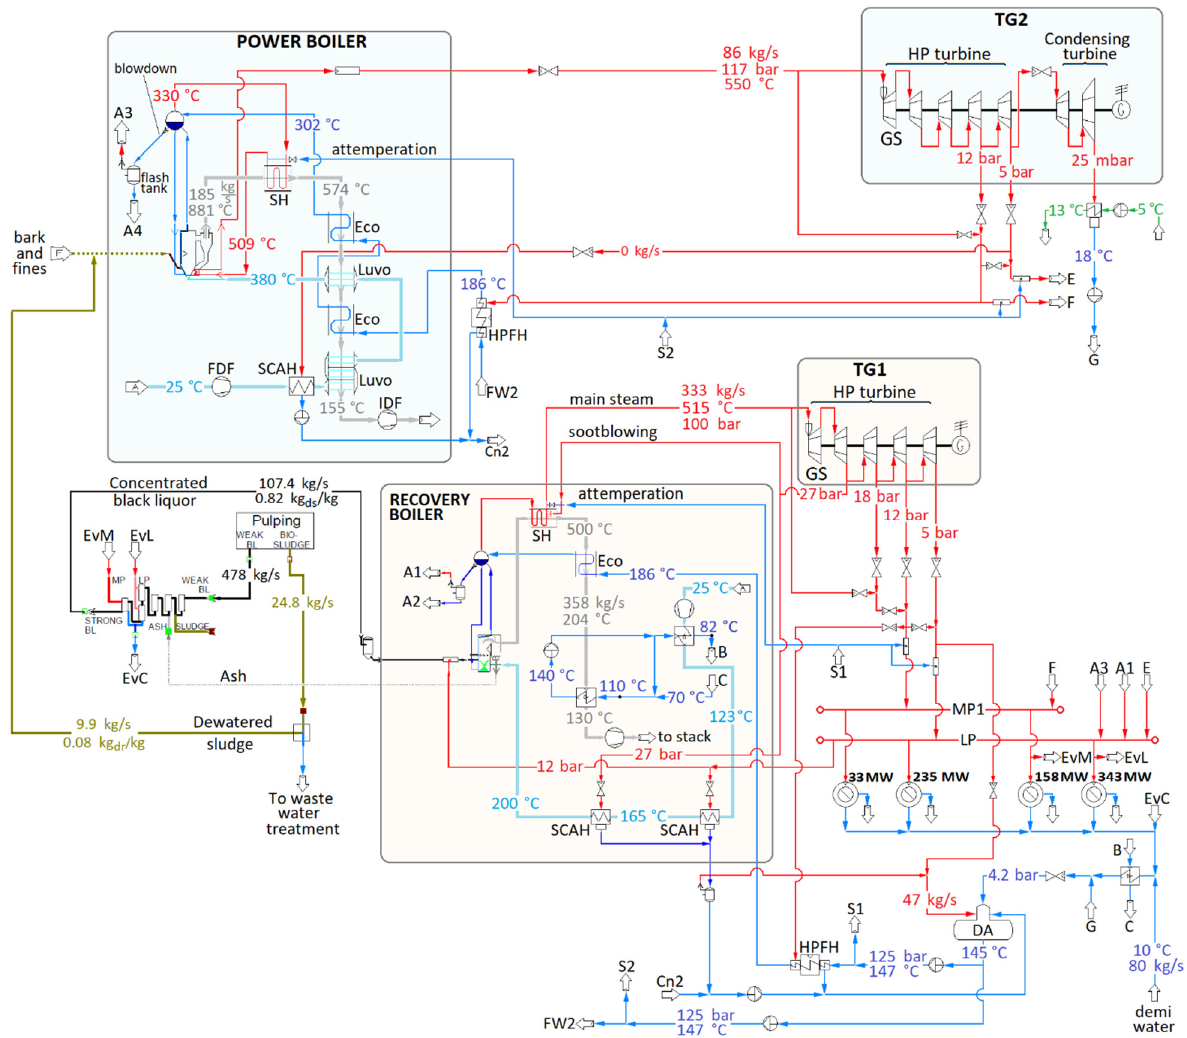
Figure 2. Boilers and steam cycles of the NorInt mill. The NorPulp recovery boiler and TG1 are otherwise similar, but, in the absence of power boiler, the dewatered sludge is mixed with black liquor in the evaporator plant, and the TG1 includes a condensing turbine. DA—deaerator; Eco— economizer; FDF—forced draft fan; GS—governing stage; HPFH—high pressure feed heater; IDF— induced draft fan; LP—low pressure; Luvo—air preheater; MP—medium pressure; SCAH—steam coil air heater; SH—superheater.